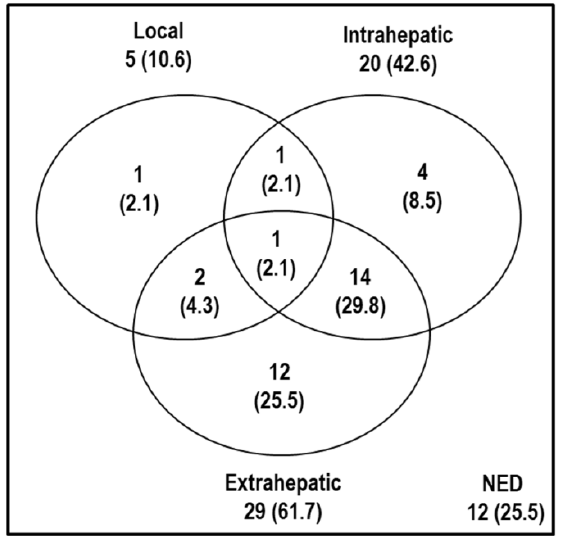
Figure 1. Patterns of disease progressions at the time of analysis. Abbreviations: Local, local progression; Intrahepatic, intrahepatic progression; Extrahepatic, extrahepatic progression; NED, no evidence of disease progression. Table 2. Univariate analysis of the pre-treatment characteristics for the free from local progression (FFLP), progression-free survival (PFS), and overall survival (OS). FFLP PFS